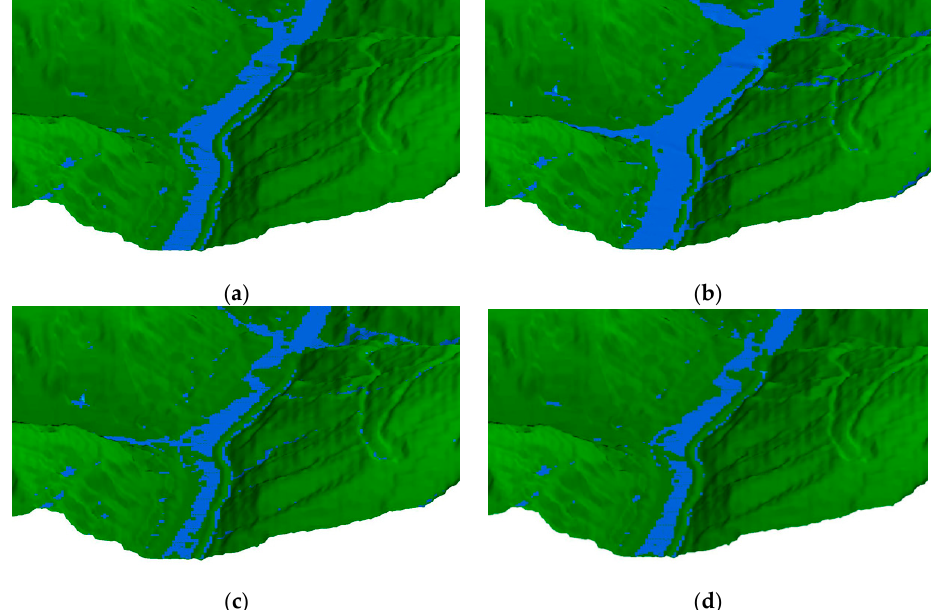
Figure 21. Flood process in the outlet of catchment. ( a ) t = 3600 s; ( b ) t = 6000 s (Peak time); ( c ) t = 10,800 s; ( d ) t = 18,000 s.